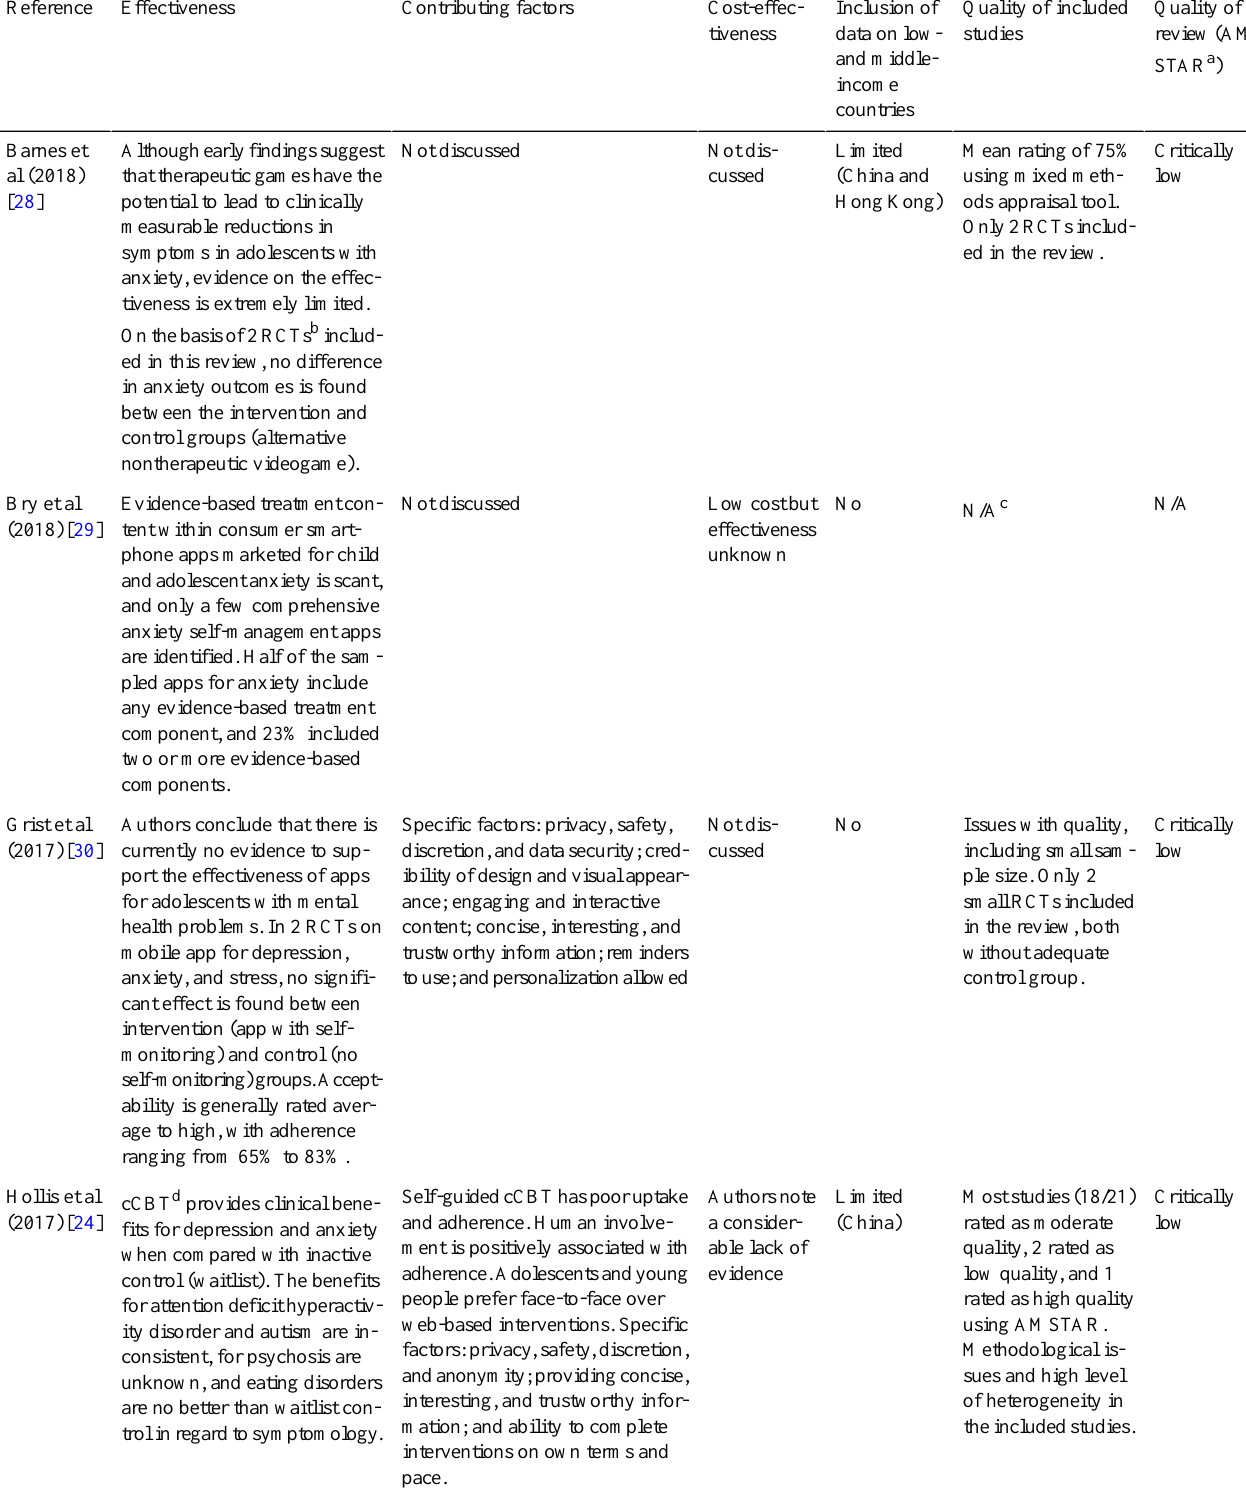
)Quality of included studiesInclusion of